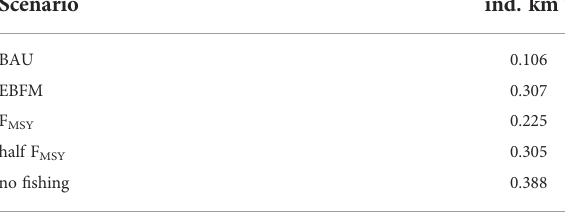
TABLE 3 Impact of alternative fi shery scenarios on harbour porpoise density in the WBS.